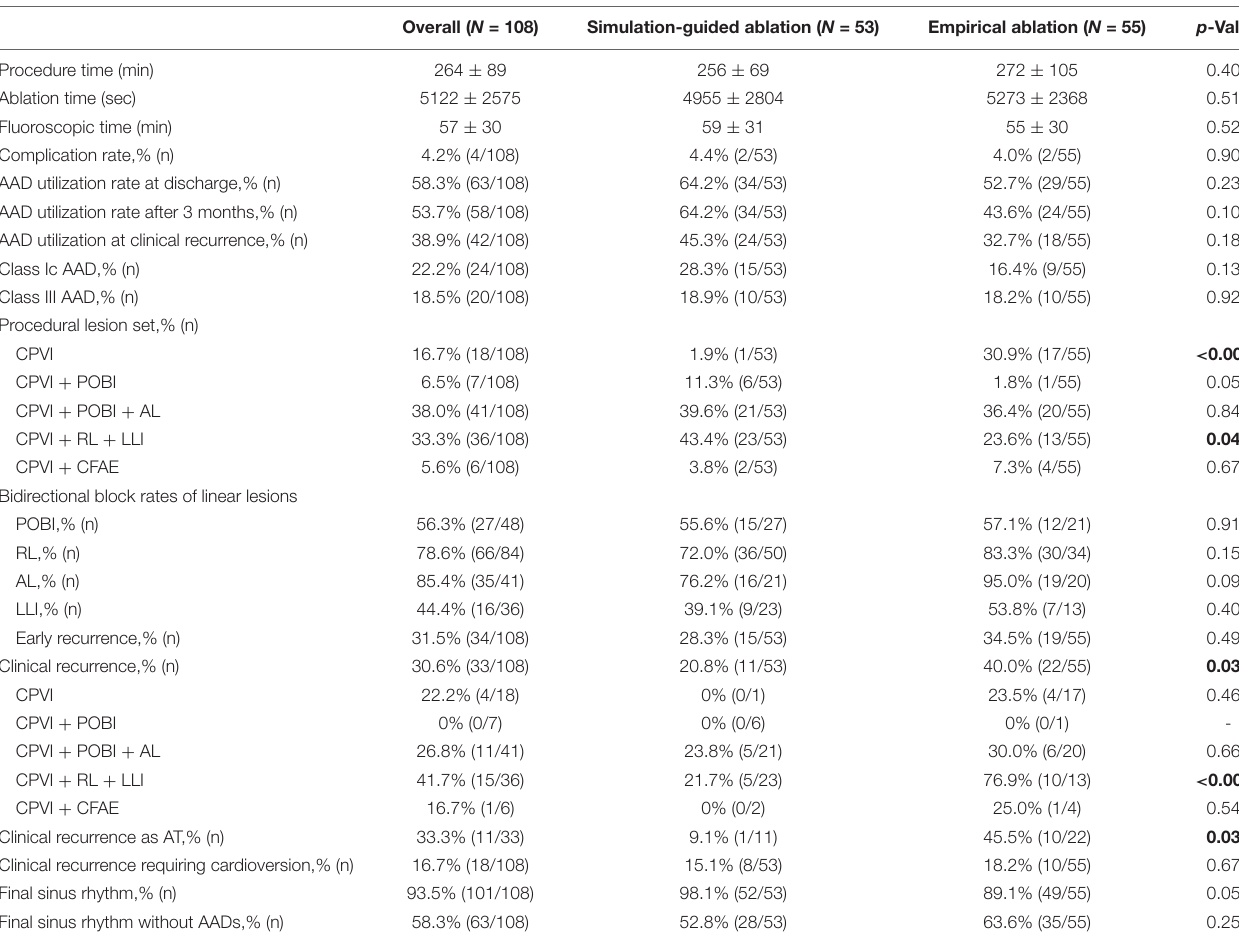
TABLE 3 | Procedure-related characteristics and the clinical rhythm